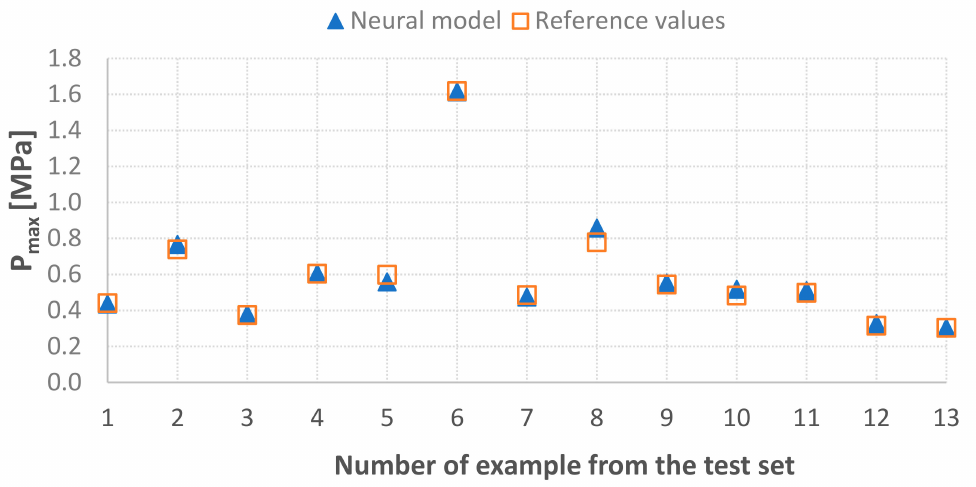
Figure 5. Summary of the determined values of the maximum methane seam pressure (p max ) and the values returned by the neural network.